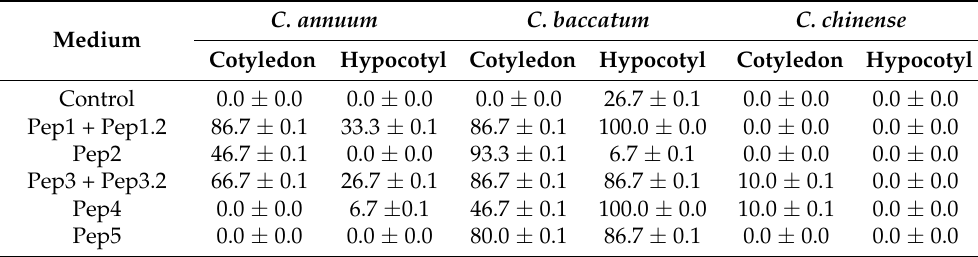
Table 7. Percentage of explants with shoots after two months in cotyledon and hypocotyl of the three Capsicum species ( C. annuum , C. baccatum and C. chinense ) in the six media used ± standard error.